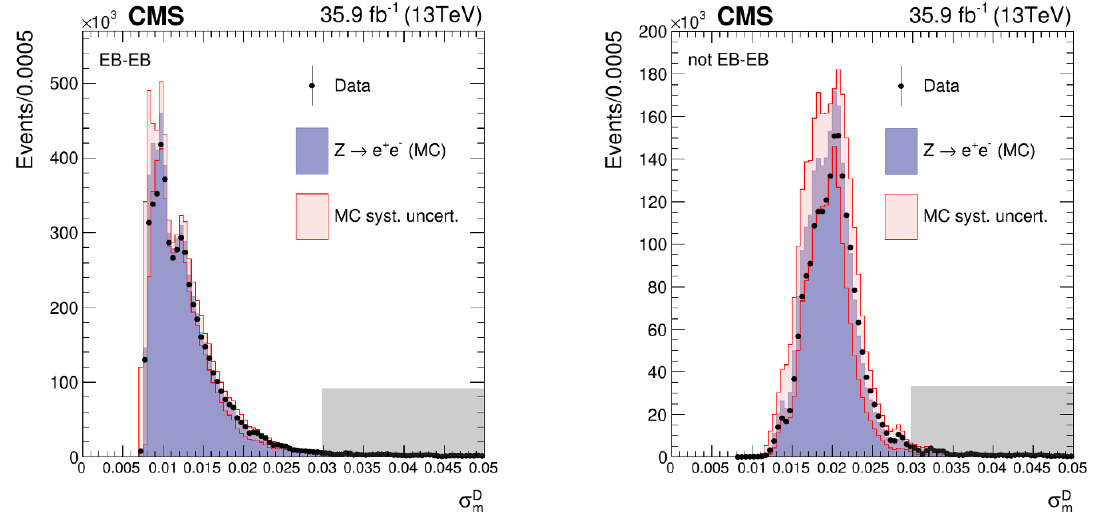
Figure 1 . Comparison of the decorrelated mass resolution estimator (cid:27) D simulation for Z ! e + e (cid:0) events where both electrons are reconstructed as photons, passing the selection de(cid:12)ned in section 5. The impact of the systematic uncertainty in the (cid:27) E =E is indicated by the red band. The distributions are shown separately for events with both electrons in the EB (left) and the remainder of the events, i.e., events with at least one photon in the EE (right). Events in the shaded gray region are discarded from the (cid:12)nal